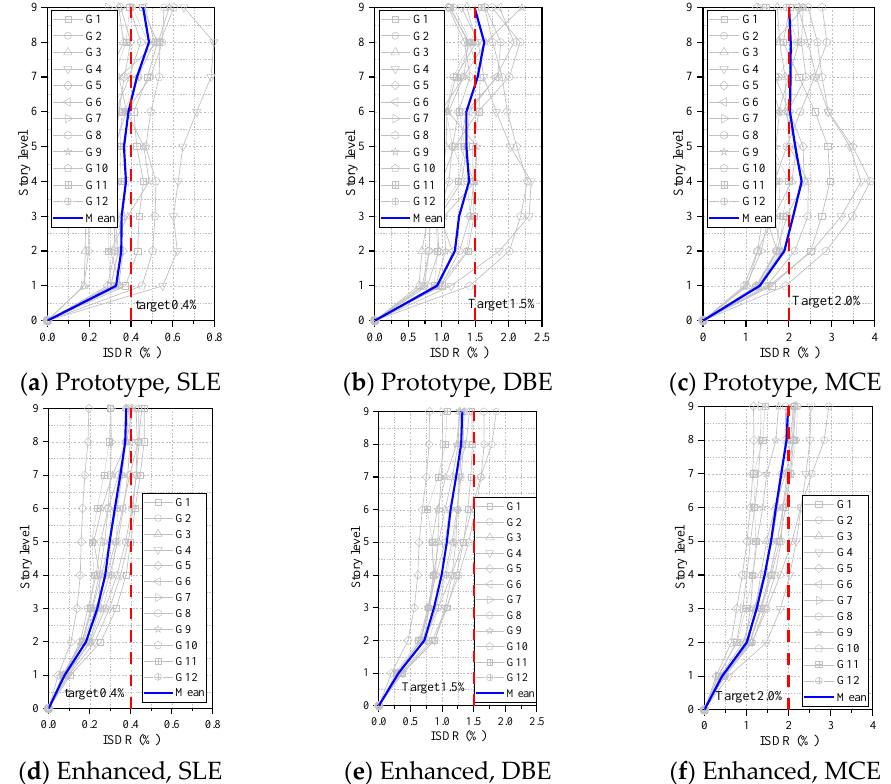
Figure 17. Inter-story drift ratio of the prototype and the enhanced SMRF.